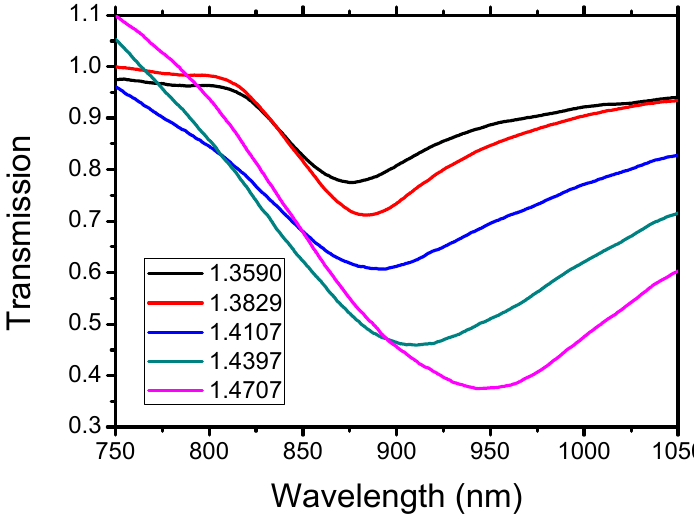
Figure 5. The spectrum for a TC-LMR sensor for glycerol solutions with a refractive index from 1.3590 to 1.4707, in increments of 0.02. 1.3590 to 1.4707, in increments of 0.02.